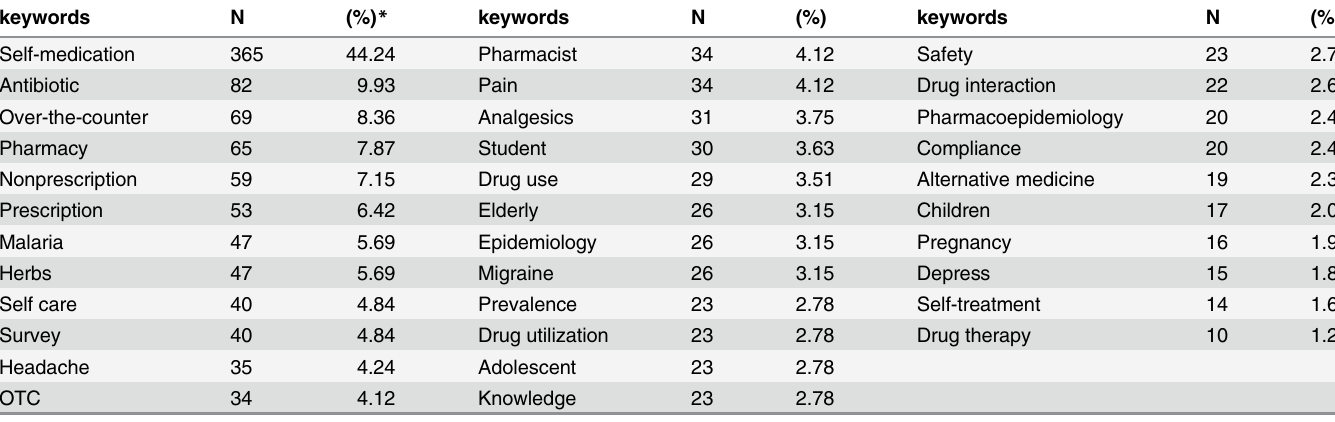
Table 3. Number of the articles with frequent